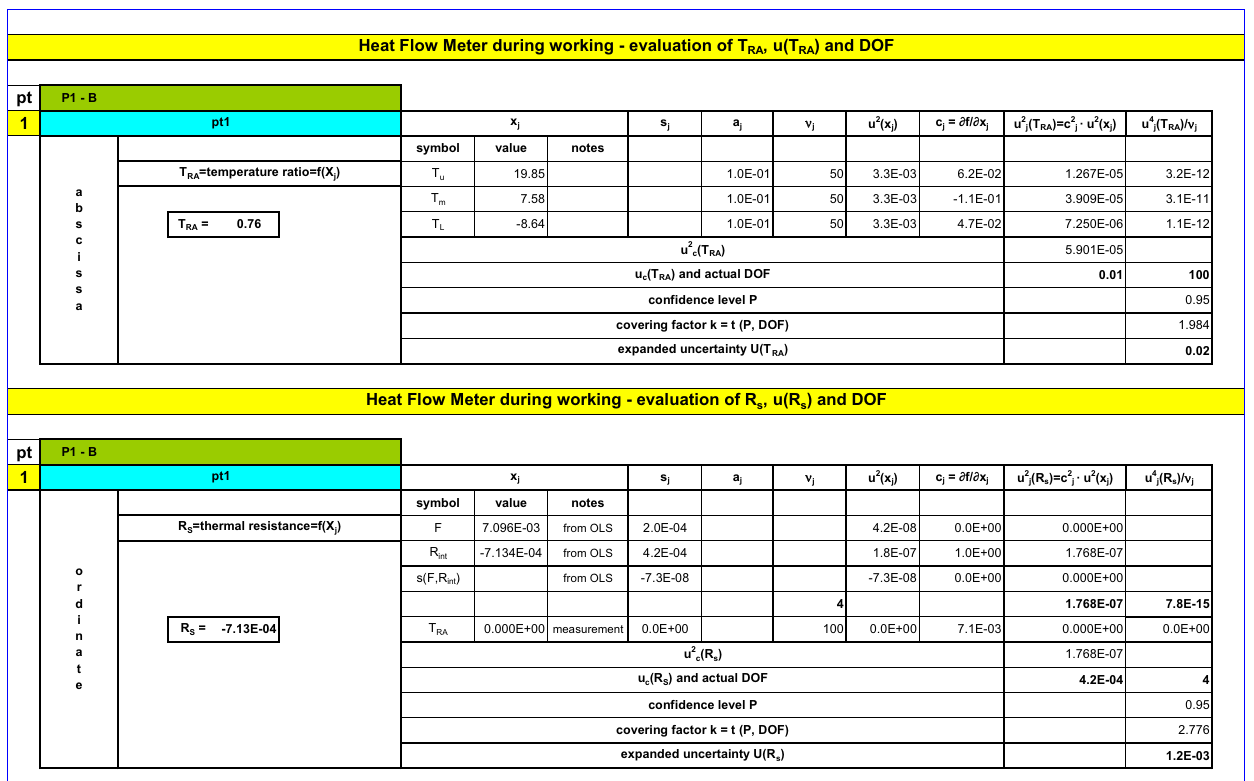
Table 4. Measures of T RA and R s , and associated combined uncertainties u ( T RA ), u ( R s ) and DOF, for materials under